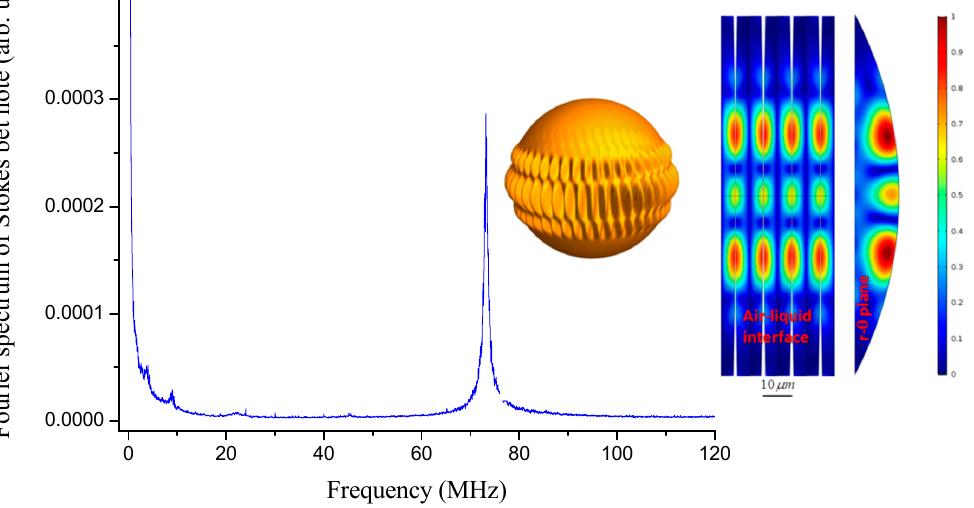
Figure 13. Left : FFT of the droplet transmission on resonance. The spectrum shows a large oscillations centered at 70 MHz (pump power of 360 µ W). Right : Finite element method (FEM) simulation. A surface acoustic mode with high transverse order is shown in a 3-D artistic illustration (yellow sphere) with purposely exaggerated modulation depth along with its absolute displacement fields (scale on color bar) at liquid-phase boundary ( θ - ϕ plane) and at radial-polar plane ( r - θ ) (All plots are reproduced with permission from [61]).